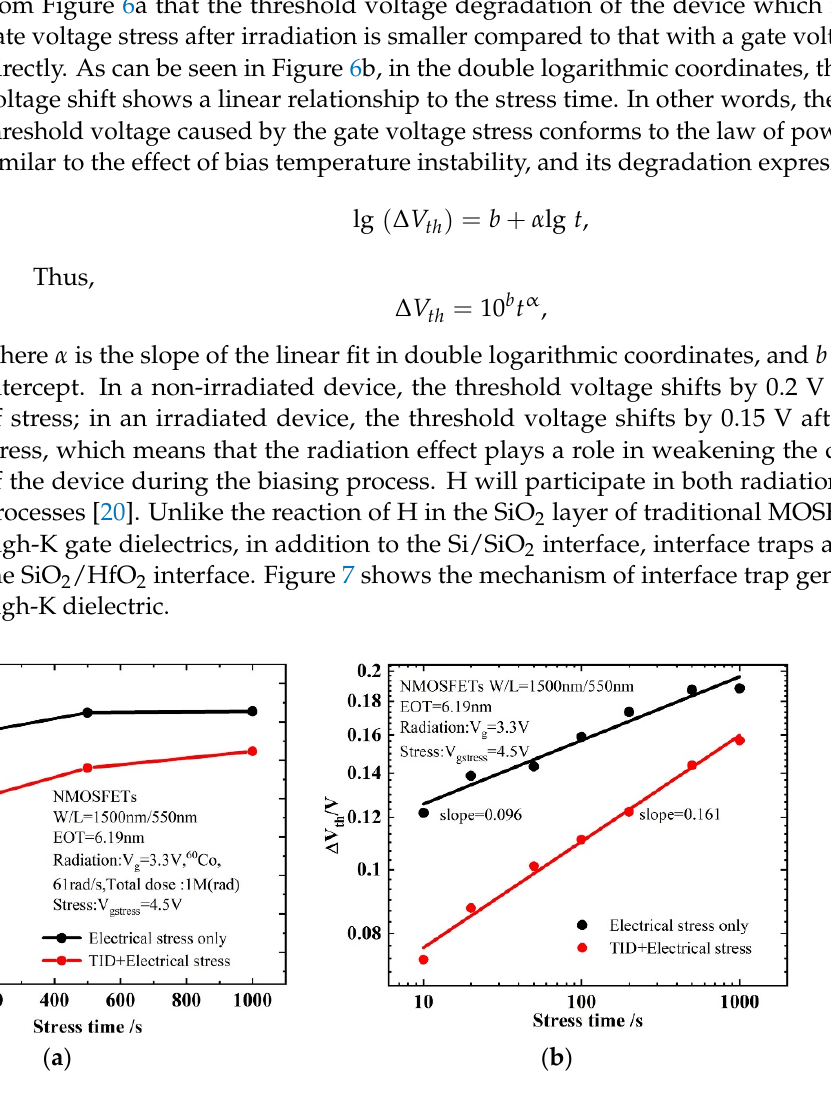
Figure 5. ( a ) Schematic diagram of STI electric field. ( b ) Schematic diagram of the parasitic channels generated by radiation in STI.